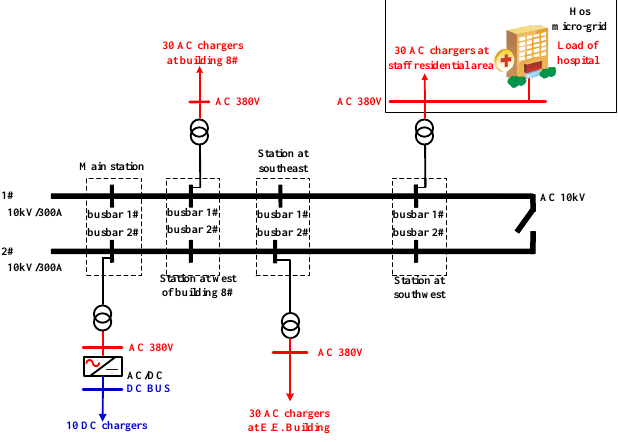
Figure 4. Electric wiring diagram of the “EV Beijing” project in BJTU.